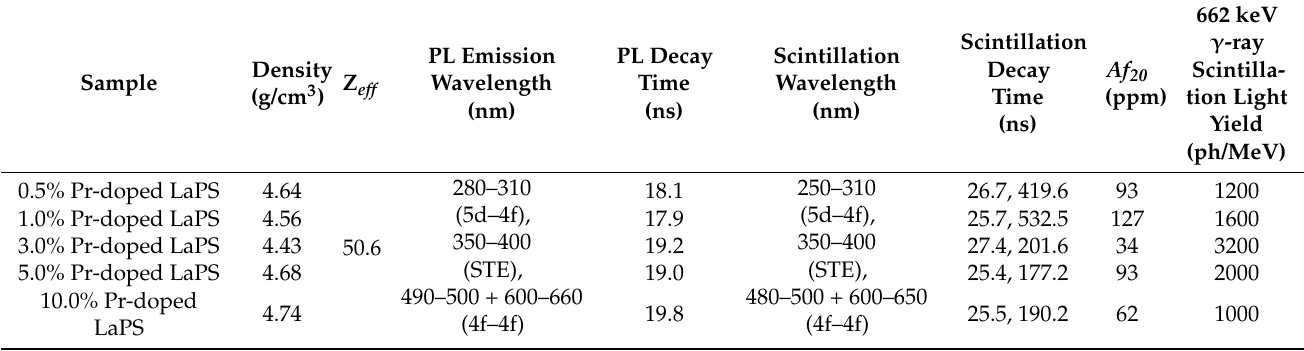
Table 1. Pr-doped LaPS summarized